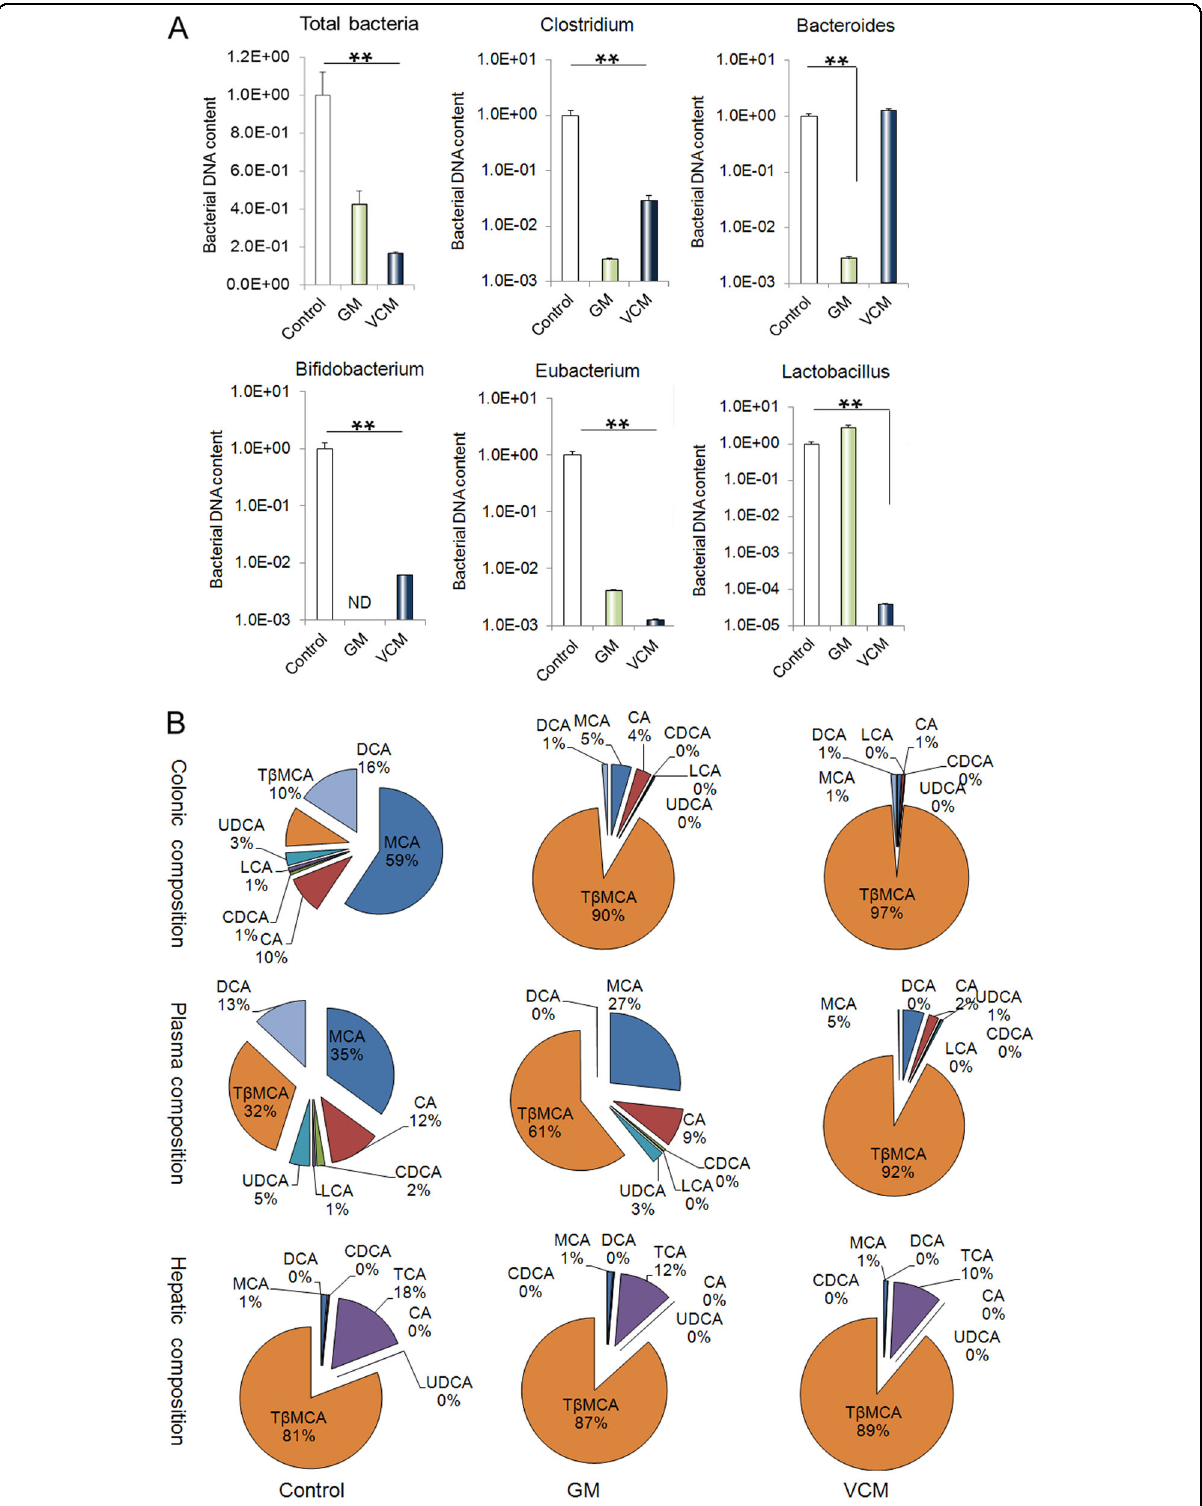
Fig. 3 Antibiotic-treated mice exhibit intestinal microbial dysbiosis and bile acid dysmetabolism. a Alterations in the relative abundance of bacteria responsible for the biotransformation of bile acids in colonic contents obtained at sacri fi ce from either untreated or antibiotic-treated animals. b Changes in the bile acid composition in colonic contents, serum or liver obtained at sacri fi ce from untreated and antibiotic-treated animals. ** p <